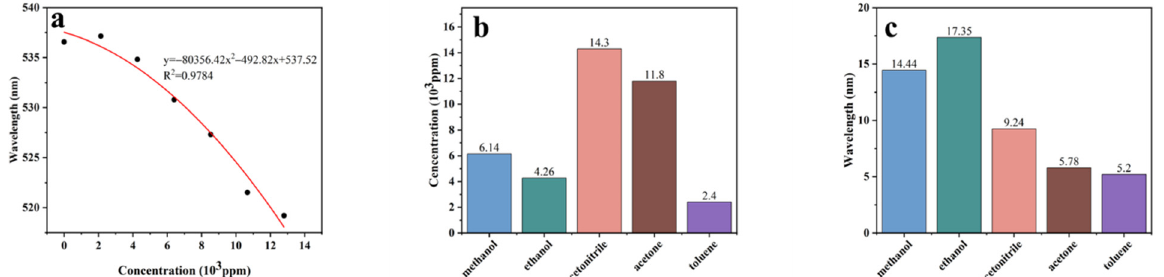
Figure 4. ( a ) The relationship between reflection peak of photonic crystal hydrogel and ethanol vapor concentration. ( b ) The lowest detection limit of the photonic crystal hydrogel for five VOCs. ( c ) The maximum redshift of the photonic crystal hydrogels for five VOCs.